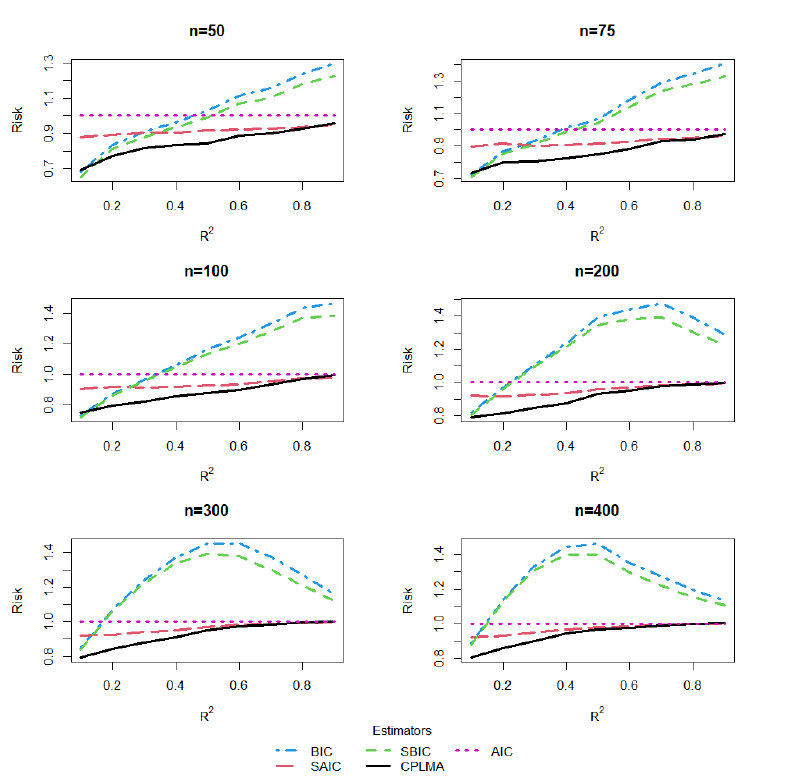
Figure 7. Risk comparisons for Design 2 when α = 0.5 and the censoring rate is about 20%.